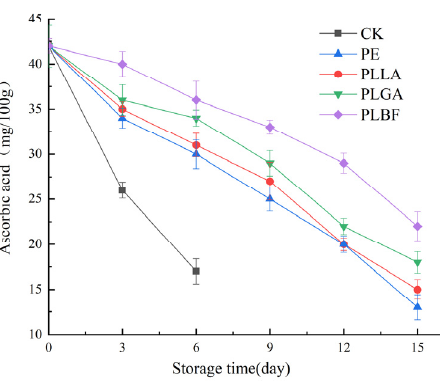
Figure 8. Changes of total ascorbic acid of Agaricus bisporus in each packaging group during storage.